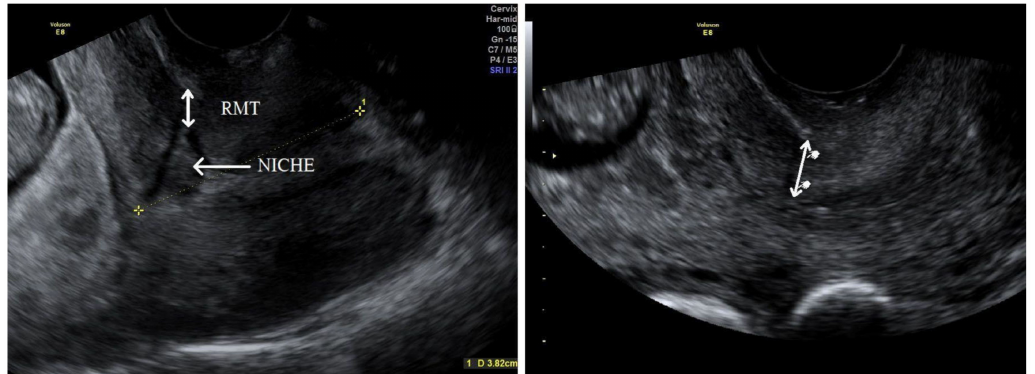
Figure 1. First-trimester midsagittal ultrasound images showing the evaluation of residual myome- trial thickness (RMT) (on the left ) in the CS scar niche participant group and evaluation of myometrial thickness at internal cervical os (on the right ) in the non-niche participant group.